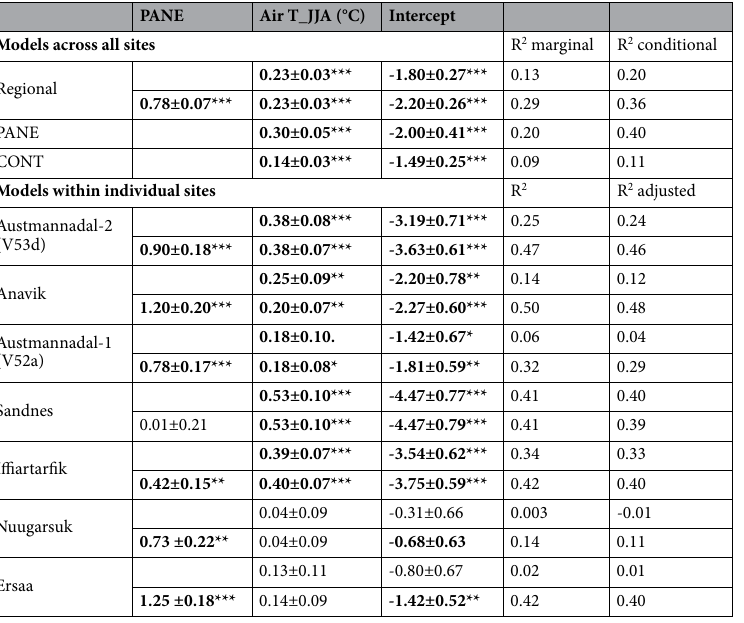
Table 2. Results of the linear mixed effect (LMM) and Linear (LM) models of the role of summer temperature (T_JJA) and nutrient availability (factor representing (PANE) and (CONT) sample) for the radial growth (RWI, Z-scores) of Salix glauca L. (1980–2016). * p < .05, ** p < .01 and *** p < .001. The effects were investigated both across all 7 sites (LMM) and for each site individually (LM), excluding the years characterized by insect outbreaks. Numbers indicate the estimates ± SE. R 2 marginal and R 2 conditional refer to the variance explained by the LMM models while R 2 and R 2 adjusted refer to the variance explained by the LM